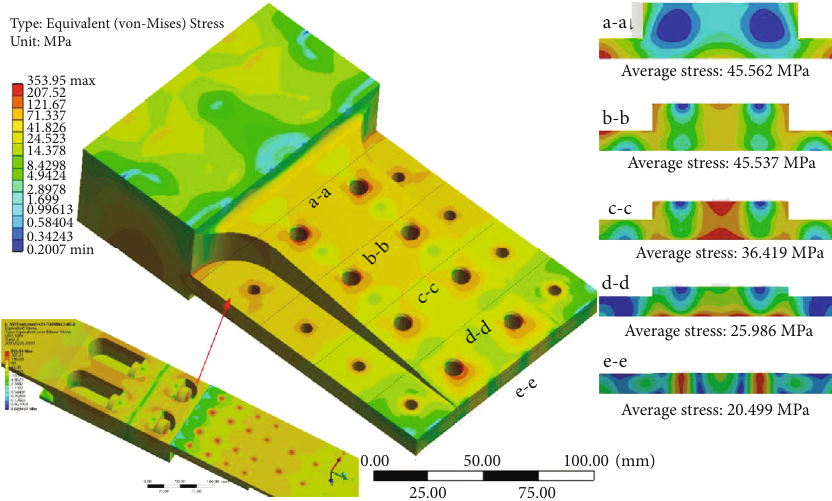
Figure 14: The stress state of the fi tting of outer wing section.